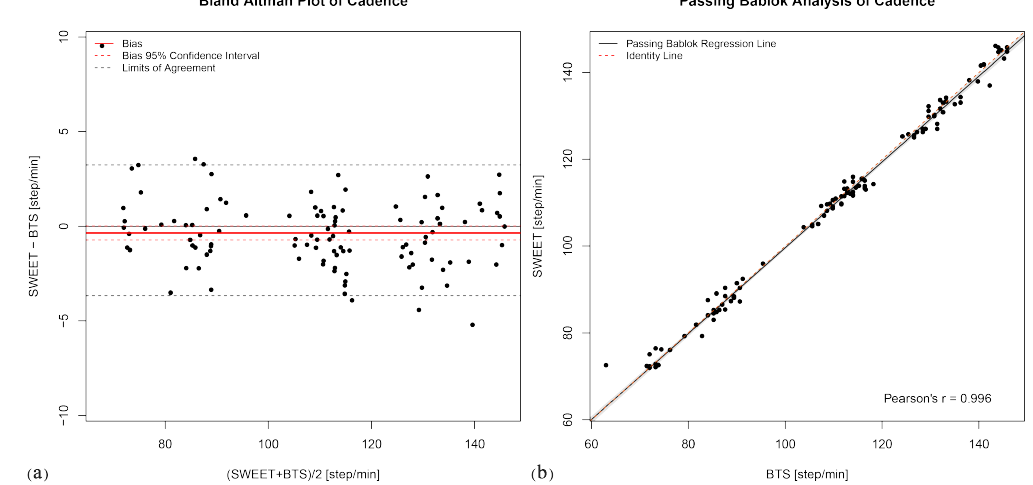
Figure 7. Cadence: ( a ) Bland–Altman plot; ( b ) Passing–Bablok regression analysis.